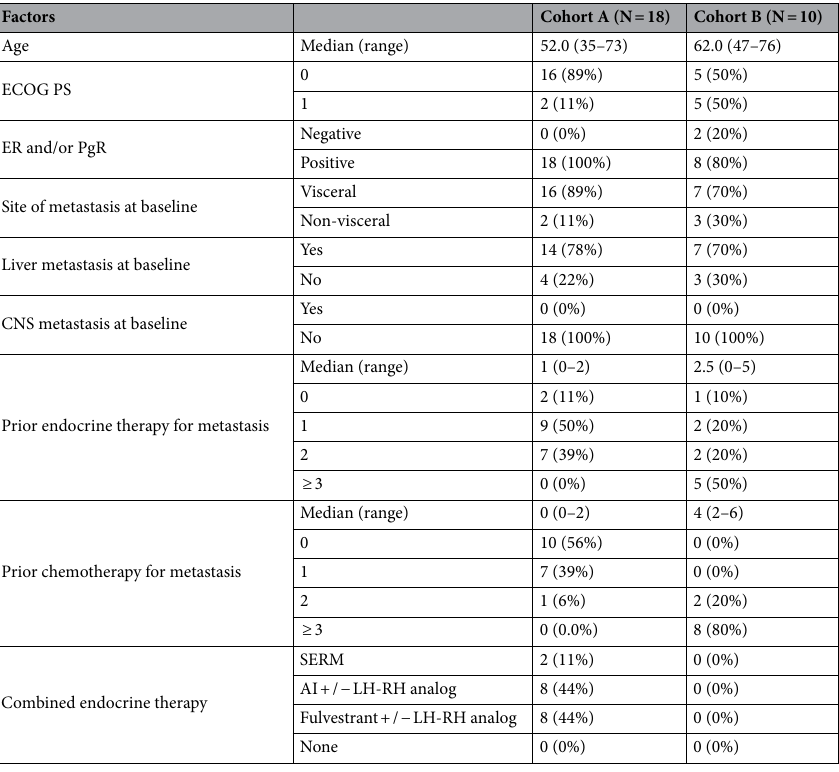
Table 1. Patient characteristics. ECOG PS Eastern Cooperative Oncology Group performance status, ER estrogen receptor, PgR progesterone receptor, CNS central nervous system, SERM selective estrogen receptor modulator, AI aromatase